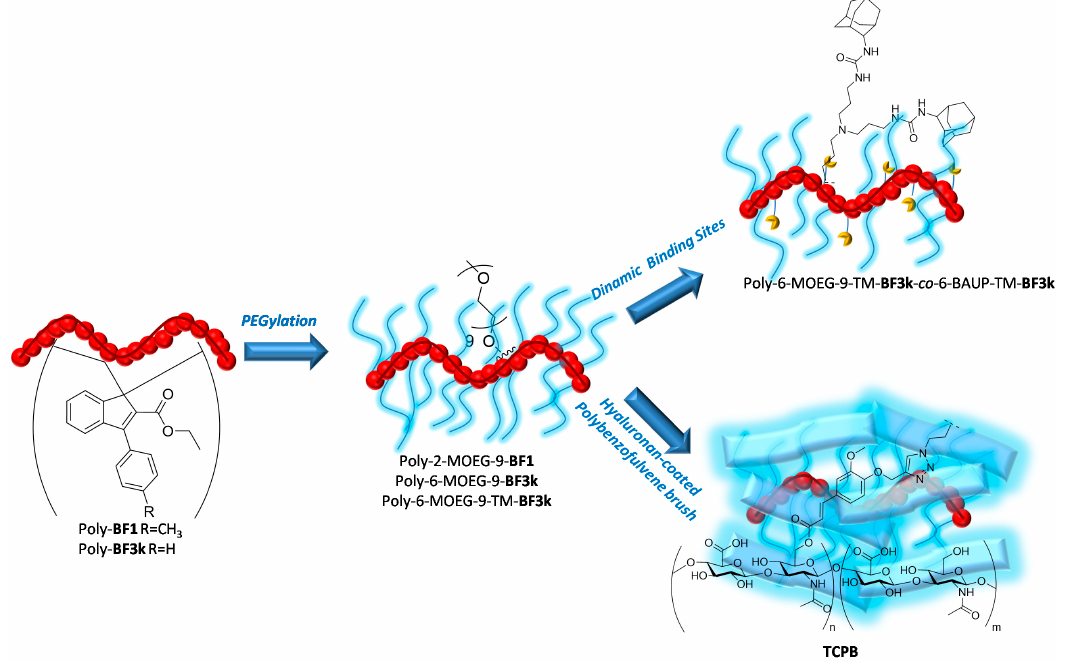
Figure 1. Development of PEGylated polybenzofulvene brushes (PPBFB) from poly- BF1 and poly- BF3k .